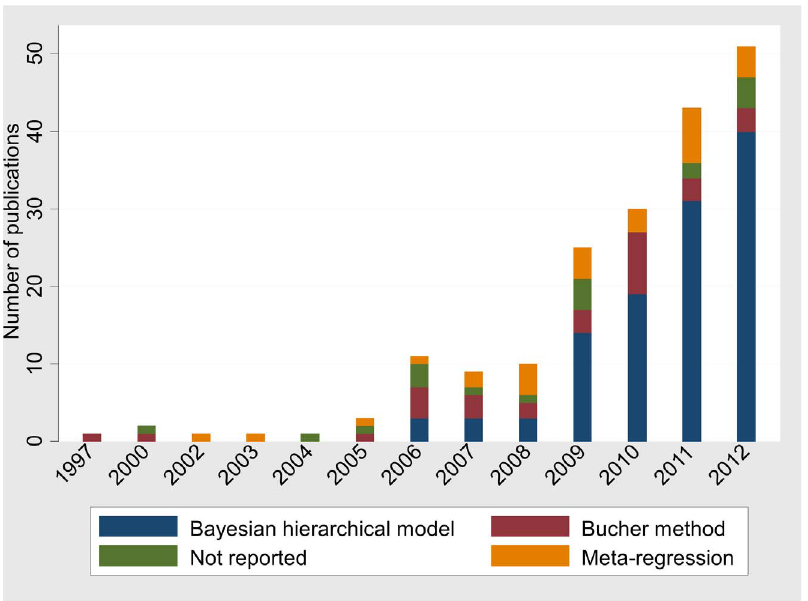
Figure 4. Number of published networks by year (1997–2012) and the Network Meta-Analysis method. Networks that used more than one method are included in all relevant categories.